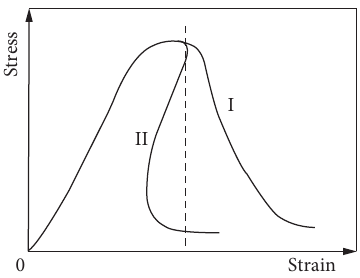
Figure 8: Rock failure types after uniaxial compression